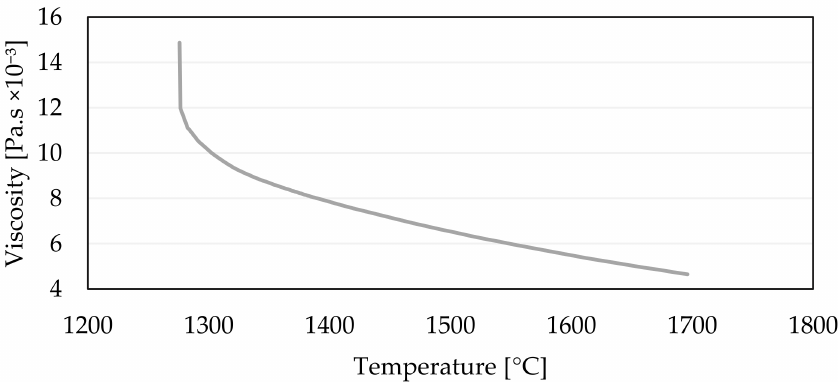
Figure 6. Viscosity as a function of temperature